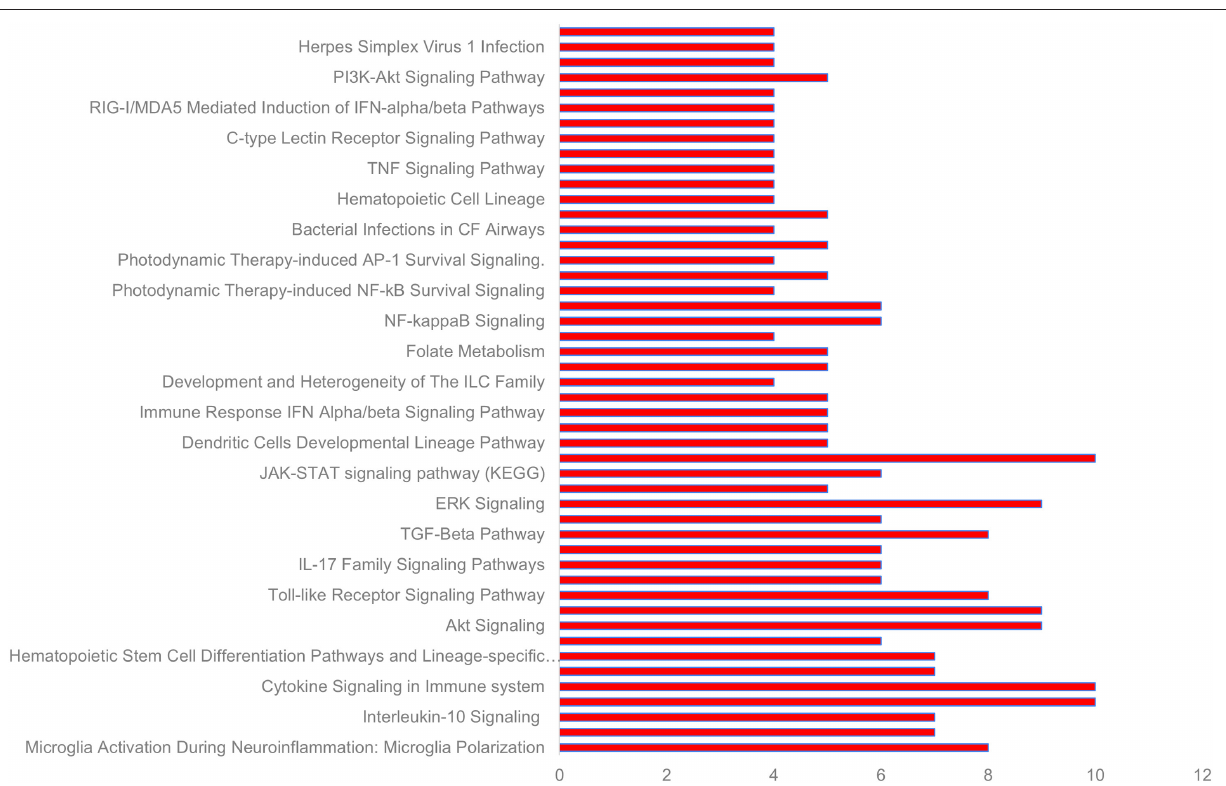
FIGURE 4 | Some of the pathways associated with cytokines significant to COVID-19 cytokine storm (see Supplementary Table 3 for complete list).